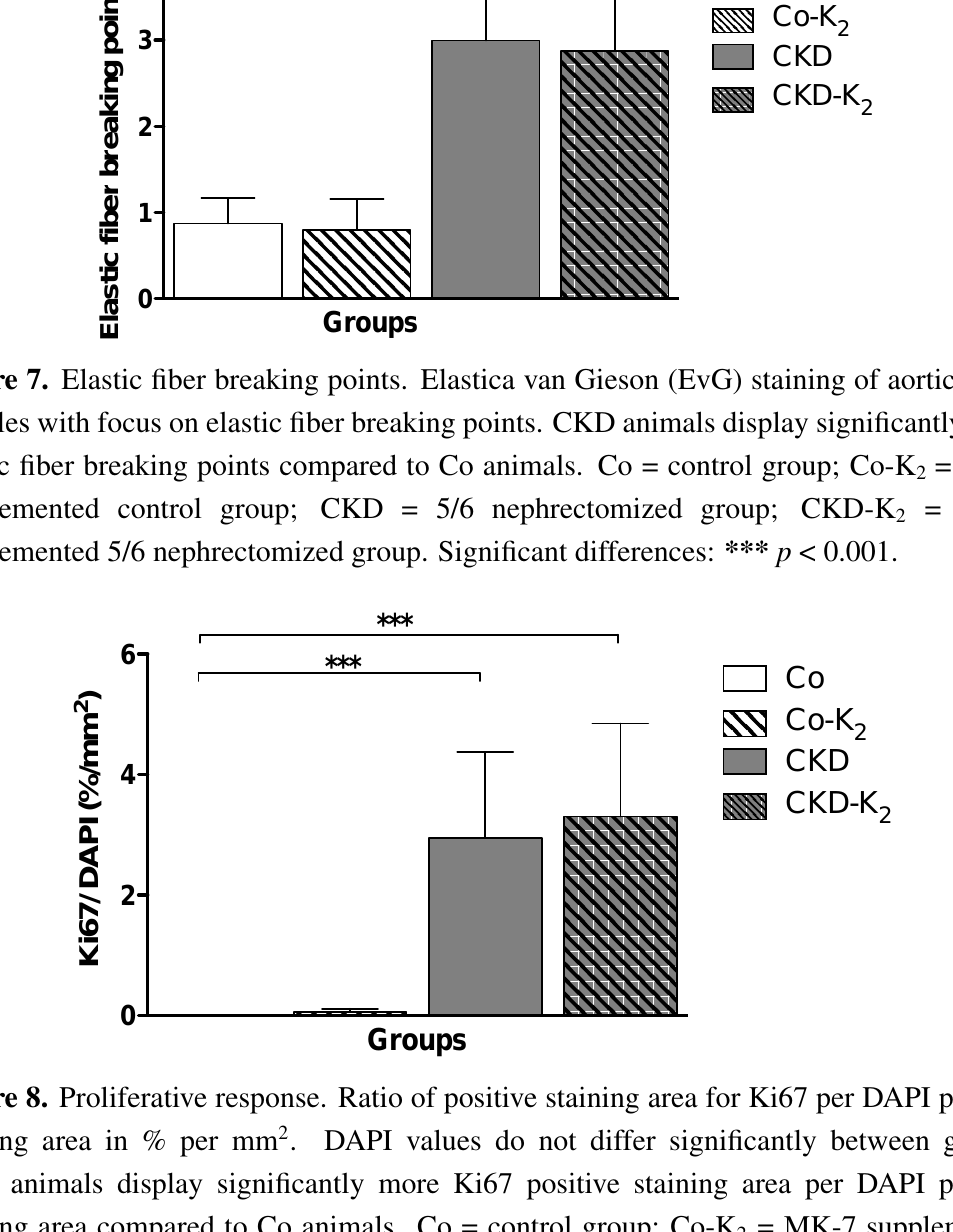
Figure 8. Proliferative response. Ratio of positive staining area for Ki67 per DAPI positive staining area in % per mm 2 . DAPI values do not differ significantly between groups. CKD animals display significantly more Ki67 positive staining area per DAPI positive staining area compared to Co animals. Co = control group; Co-K 2 = MK-7 supplemented control group; CKD = 5/6 nephrectomized group; CKD-K 2 = MK-7 supplemented 5/6 nephrectomized group; mm = millimeters. Significant differences: *** p < 0.001.